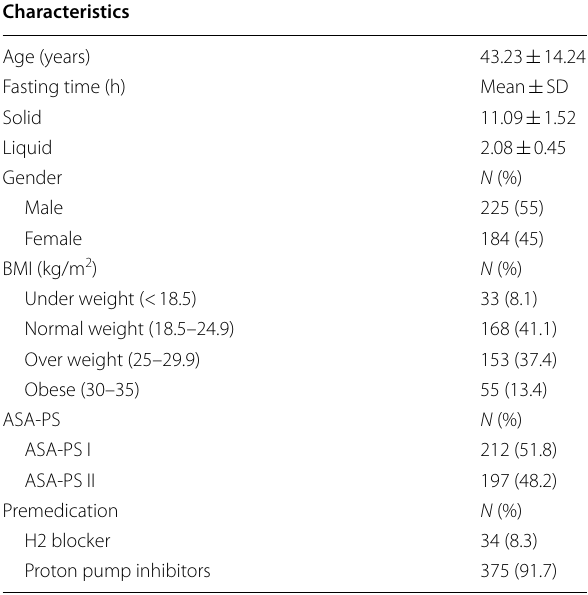
Table 1 Characteristics of study population Characteristics